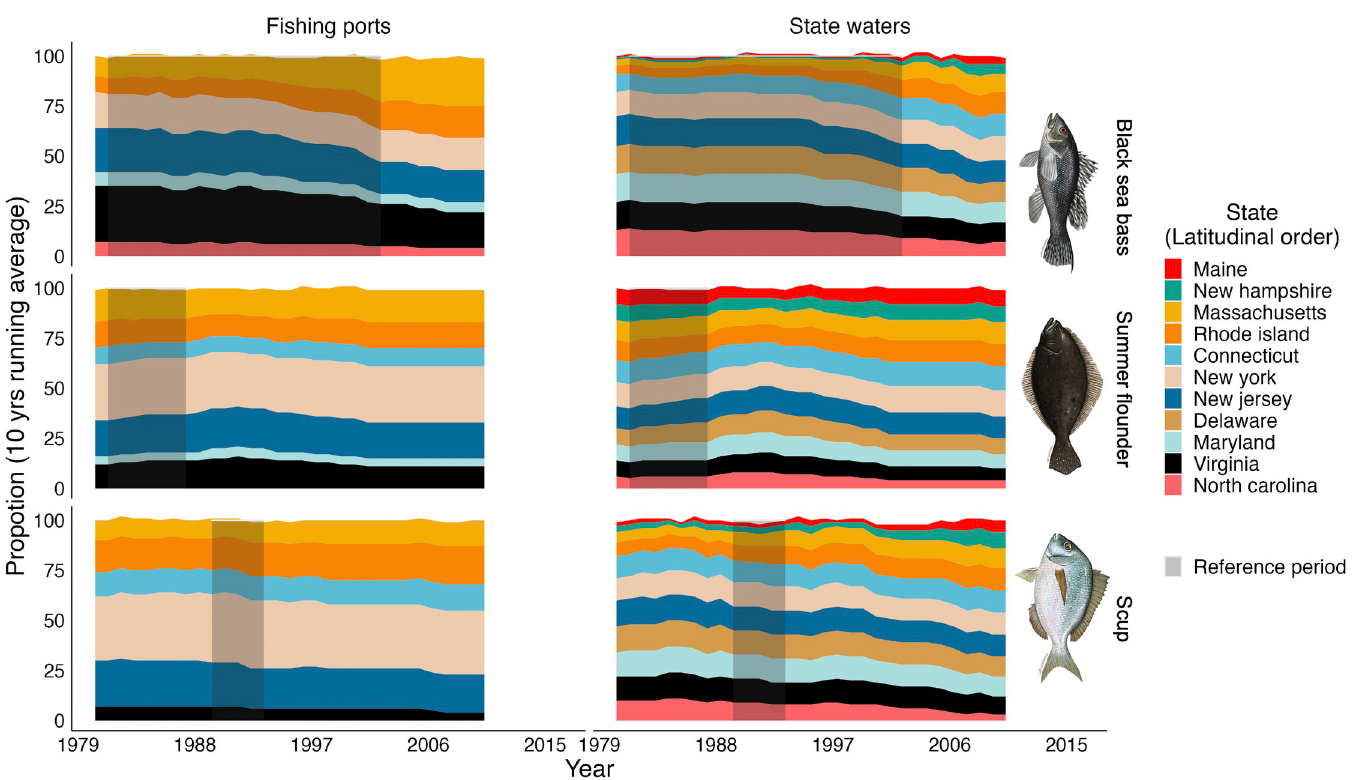
Fig 6. Historical proportion of trawl survey data as Catch Per Unit of Effort (CPUE) for each state and species by spatial approach. Proportion presented in 10 years running mean percentage. States presented latitudinally from north to south. Grey shade represents the reference period for quota allocation. Fish images from MAFMC